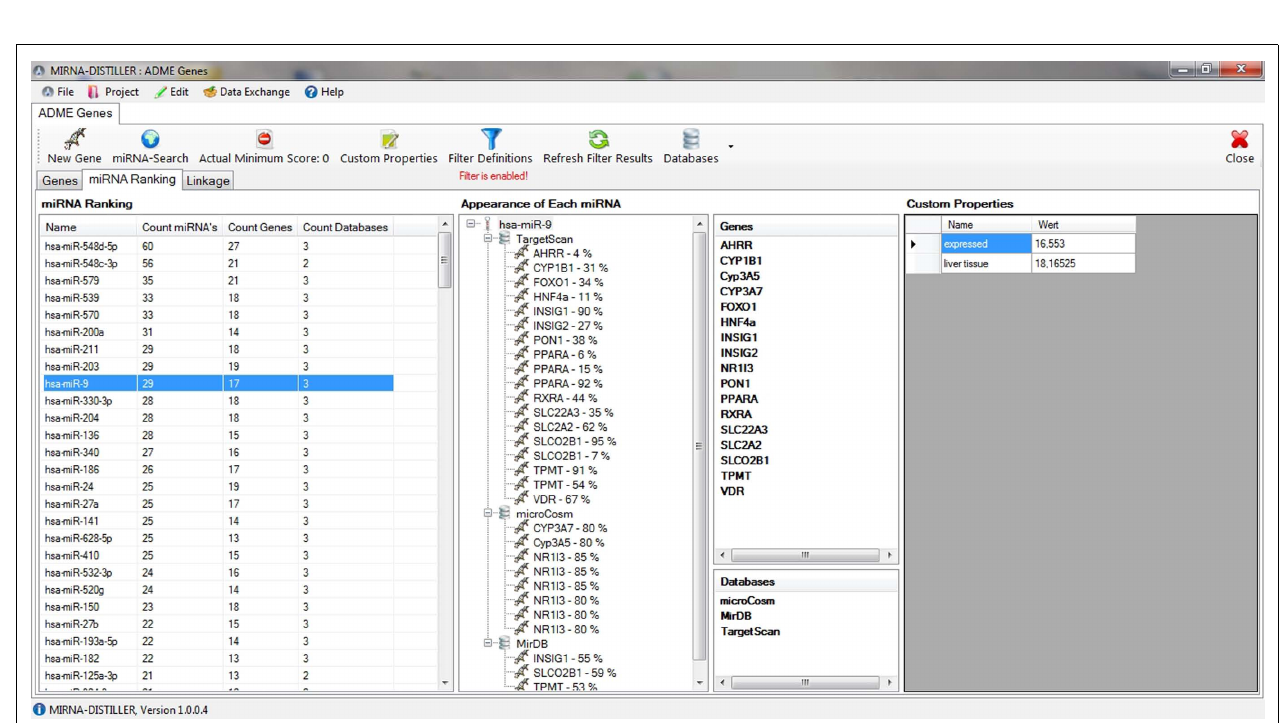
FIGURE 3 | miRNA Ranking. All miRNAs are ranked by their occurrence in the preloaded gene set. It is also possible to sort the miRNAs alphabetically. Furthermore the program allows to predict target genes for all previously selected miRNAs.